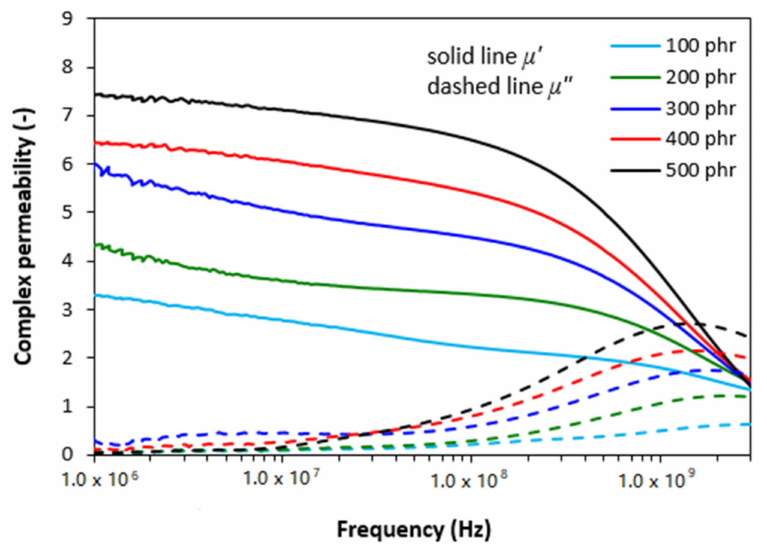
Figure 1. Frequency dependences of real ε (cid:48) and imaginary ε (cid:48)(cid:48) parts of complex permeability for ferrite filled